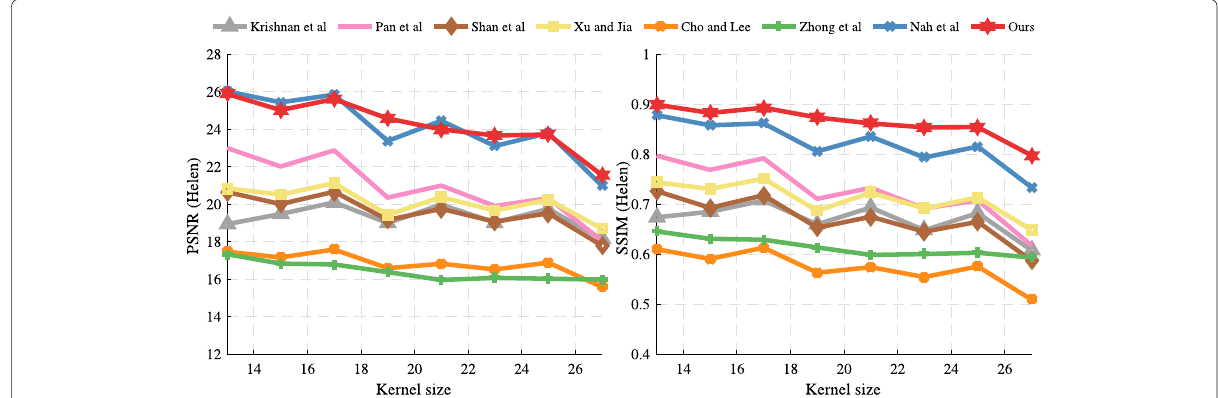
Fig. 6 Quantitative evaluation on Helen dataset. Here, we choose 100 clear images from Helen dataset and convolute these images with 80 blur kernels to generate 8000 blurred images for testing